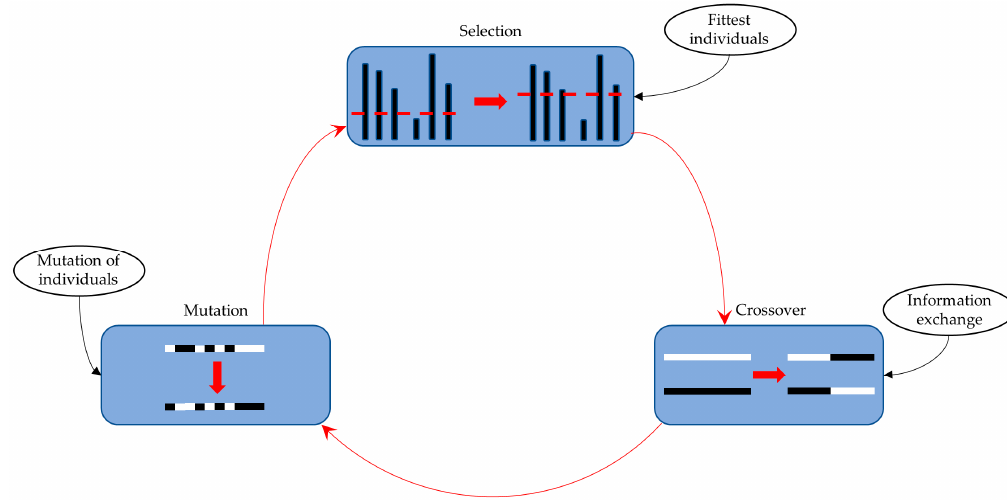
Figure 13 . Reproduction cycle of a GA [39]. Figure 13. Reproduction cycle of a GA